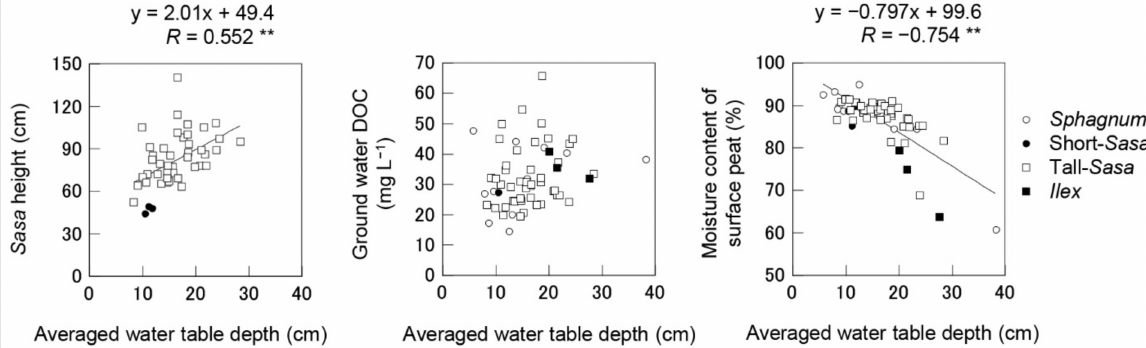
Figure 5. Relationships between averaged water table depth and Sasa height, ground water DOC or moisture content of surface peat at grid points. ** indicates significant at p < 0.01.